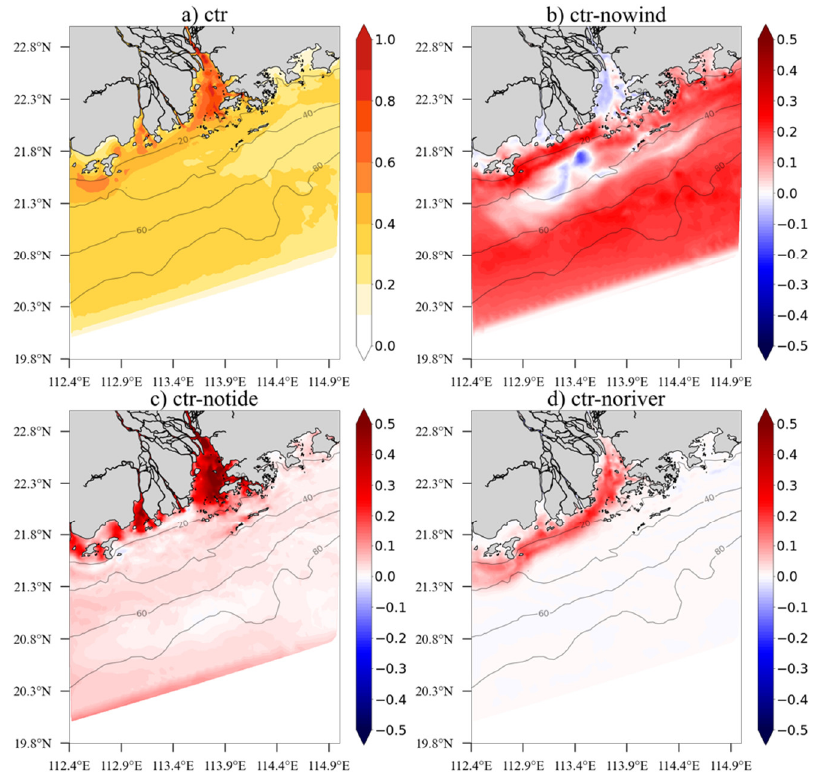
Figure 11. The standard deviation (cm/s, shaded) in the sensitivity experiments: ( a ) control experi- ment; ( b ) the difference between control and no_wind cases; ( c ) the difference between control and no_tide cases; ( d ) the difference between control and no_river cases.